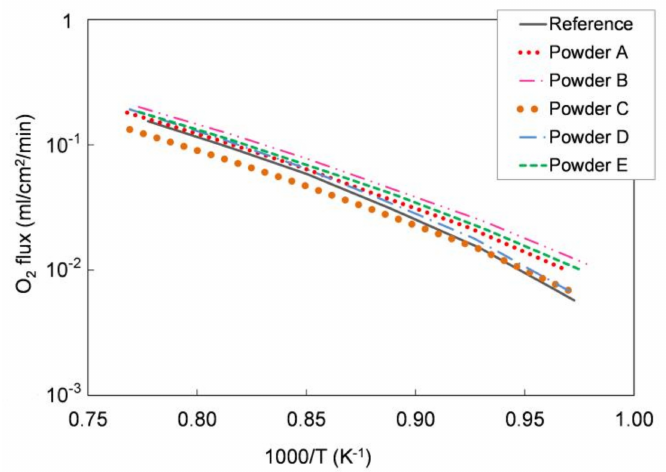
Figure 5. Oxygen flux normalized with respect to the process driving force as a function of temperature measured for pellets prepared with the five di ff erent LSCF powders, compared with that measured for a reference LSCF powder pellet. Samples thickness = 1 mm. Experimental error approx.